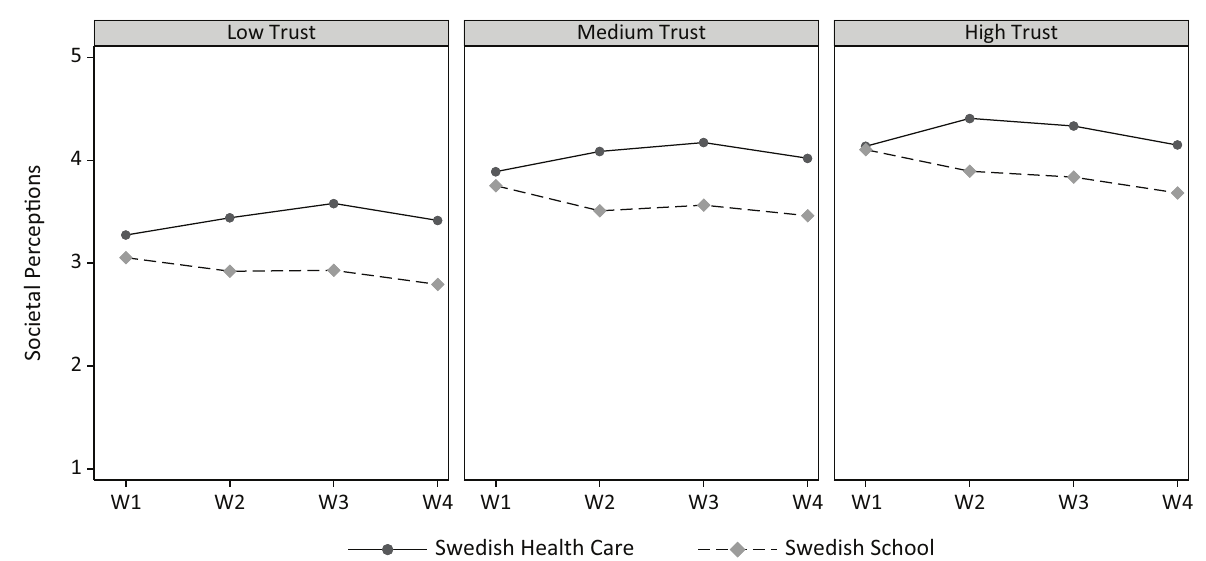
Figure 1. Development of Swedish health care and school perceptions over time (mean values). Notes: Mean values of Swedish health care (1–7) and school perceptions (1–7) over time; minimum number of respondents at each wave (W1: N = 2,065; W2: N = 1,719; W3: N = 1,056; W4: N = 1,498); general media trust is divided into three